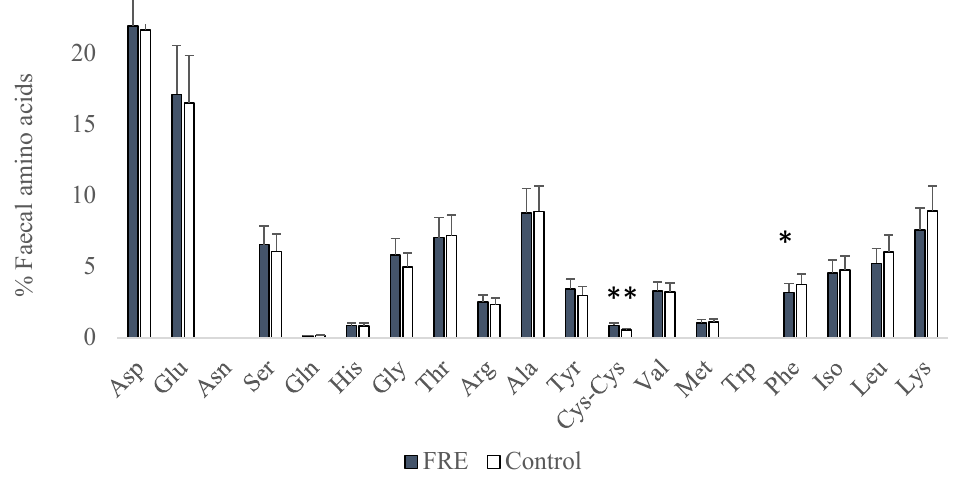
Figure 2. Amino acid proportions (%) in faeces from FRE (food-responsive enteropathy) and control dogs (* p < 0.05; ** p < 0.01). Correlations between faecal amino acids and faecal parameters (fat and humidity), BCS, and CIBDAI indices are shown in Table 3. Faecal fat percentage was negatively cor- related with Phe (r = −0 .62, p = 0.030), Lys (r = −0 .65, p = 0.022), and Leu (r = −0 .57, p = 0.050). Faecal humidity percentage correlated positively with Gly (r = 0.59, p = 0.045) and nega- tively with Leu (r = −0 .66, p = 0.018). No correlation was found with BCS or CIBDAI. The correlation between faecal amino acids and SCFAs was also investigated (Table 4). The concentration of SCFAs between FRE and healthy dogs was quantified in a previ- ous study [9]. Total SCFAs correlated positively with Phe (r = 0.80, p = 0.002), Ile (r = 0.75, p = 0.005), and Leu (r = 0.92, p = 0.0001); whereas a negative correlation was observed with Gly (r = −0 .85, p = 0.0005) and Cys-Cys (r = − 0.61, p = 0.035). The SCFA that presented the highest number of correlations was butyric acid (C4), which correlated positively with amino acids Val (r = 0.67, p = 0.017), Met (r = 0.68, p = 0.015), Ile (r = 0.77, p = 0.003), and Leu (r = 0.80, p = 0.001), while negatively with Gly (r = − 0.78, p = 0.002). Valeric acid (C5) and isovaleric acid (IC5) also presented a high number of correlations. Isovaleric acid cor- related negatively with Gly (r = − 0.59, p = 0.042), Tyr (r = − 0.59, p = 0.042), and Cys-Cys (r = − 0.60, p = 0.039), and C5 correlated positively with Leu (r = 0.59, p = 0.043) and negatively with Gly (r = − 0.61, p = 0.034). However, the C2, C3, and IC4 presented a lower number of correlations with faecal amino acids. Thus, C2 correlated negatively with Ser (r = − 0.58, p = 0.049), and IC4 correlated positively with His (r = 0.64, p = 0.026). However,C3 correlated positively with Phe (r = 0.62, p = 0.030), and a tendency was observed with Leu (r = 0.56, p = 0.060).